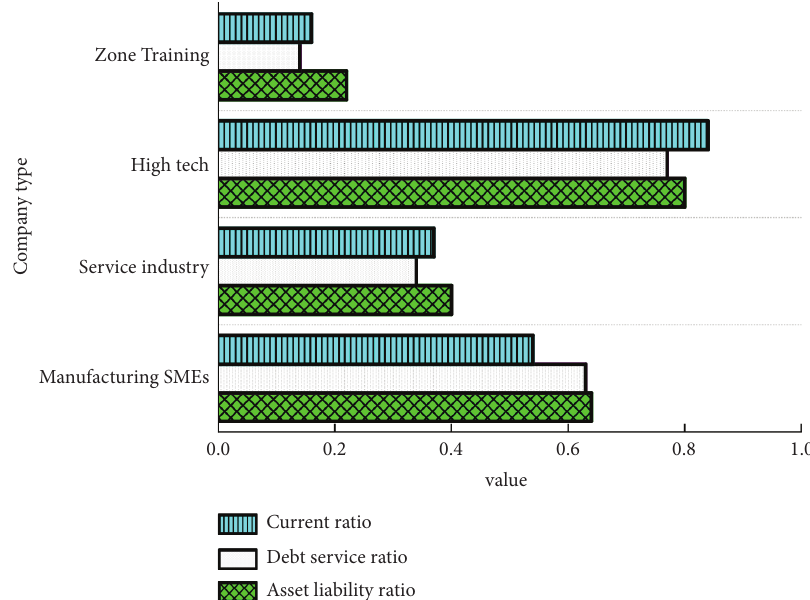
Figure 4: Asset liability ratio, debt service ratio, and current ratio of different enterprises.